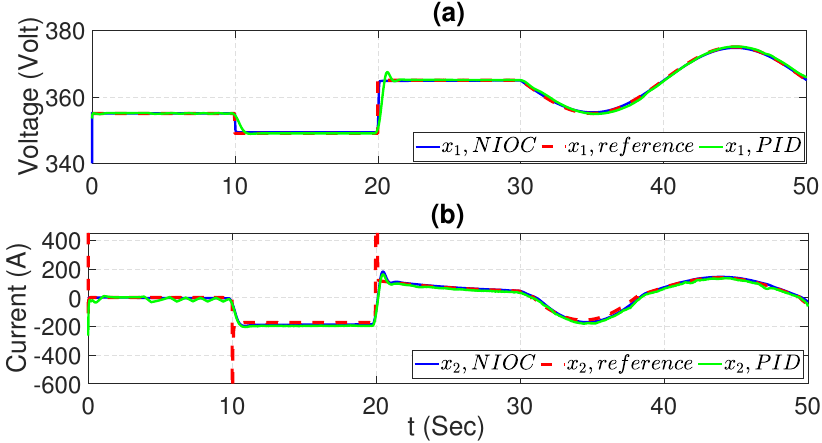
Figure 10. MES battery bank SOC comparison with and without AES.